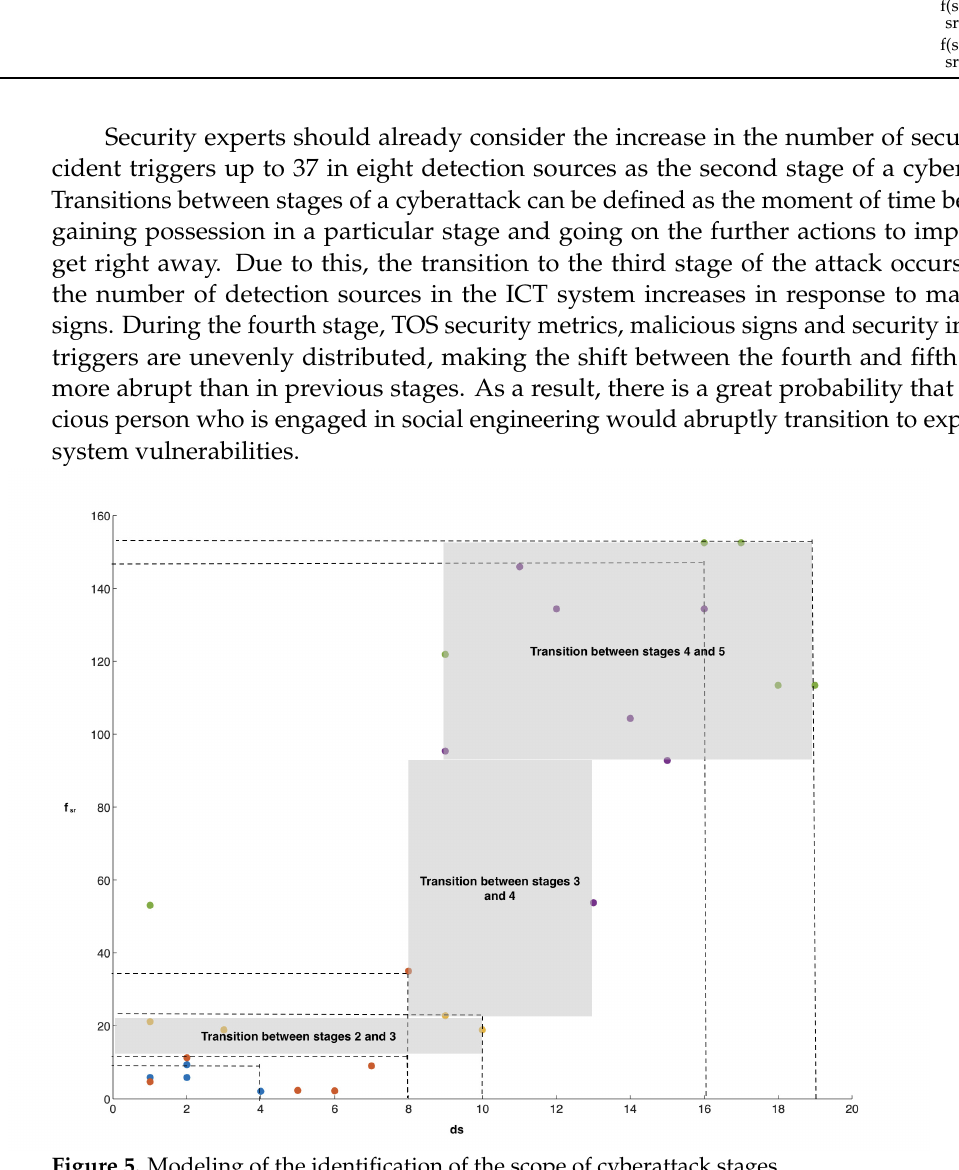
Figure 5. Modeling of the identification of the scope of cyberattack